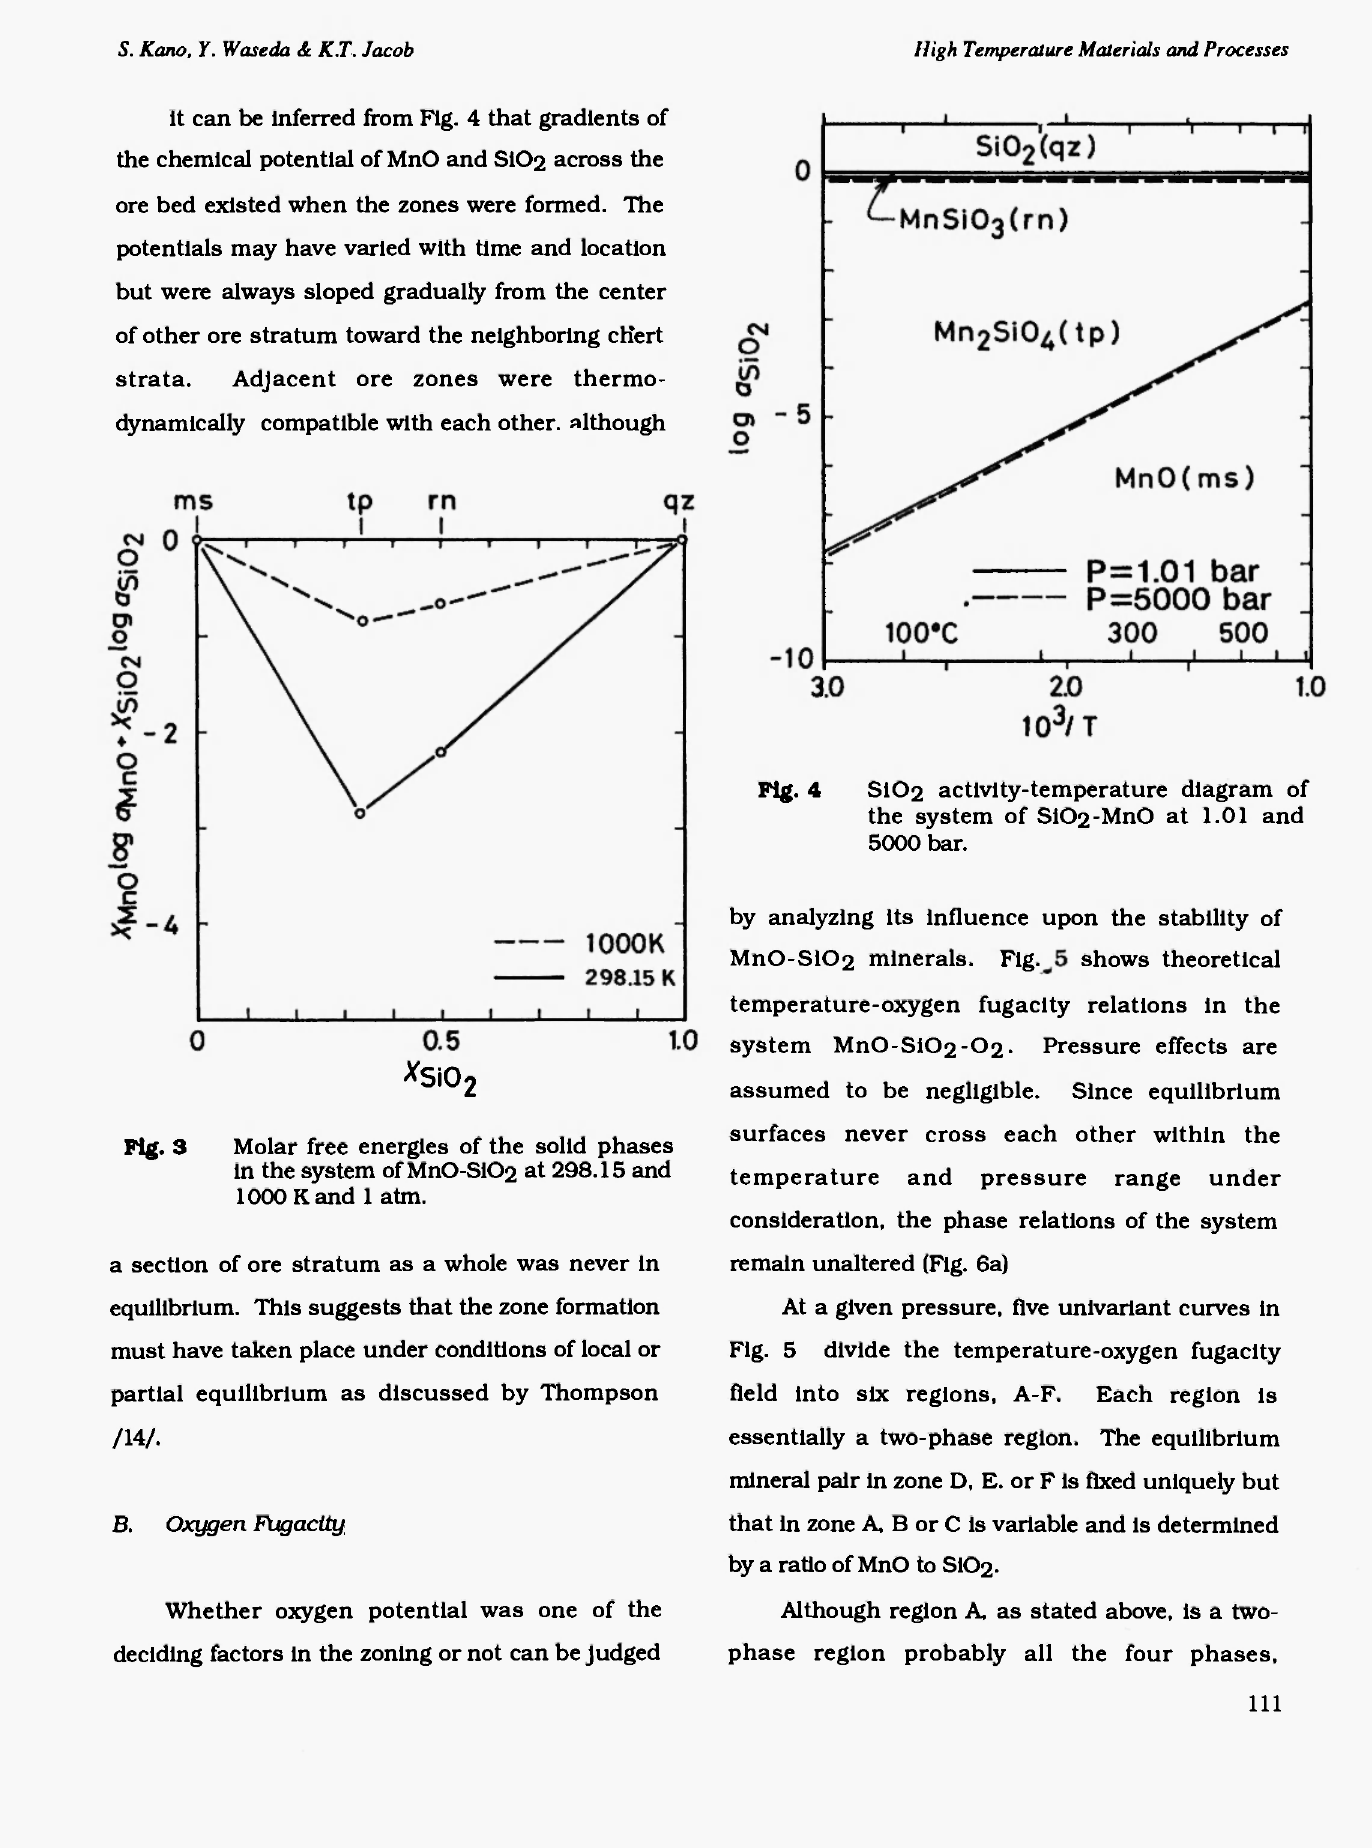
Fig. 3 Molar free energies of the solid phases in the system of MnO-SiC>2 at 298.15 and 1000 Κ and 1 atm.